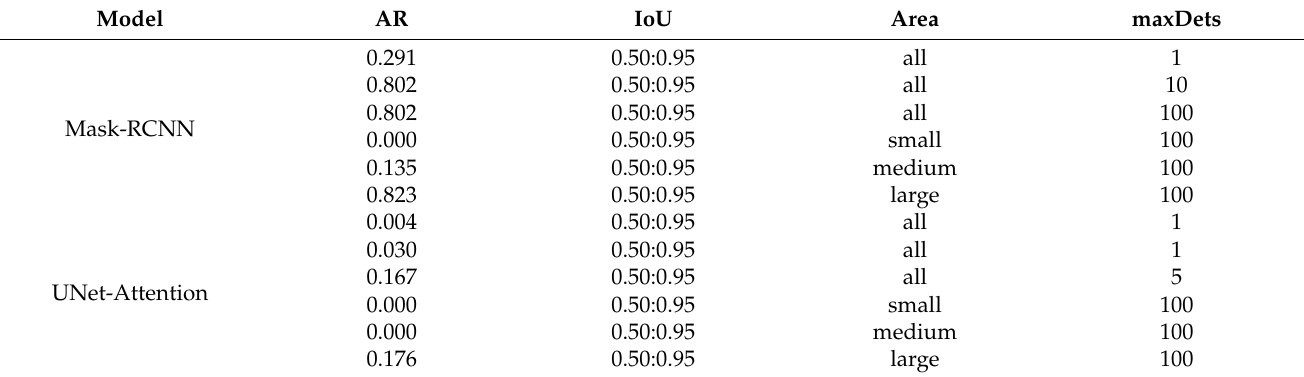
Table 2. The Average Recall (AR) rates of Mask-RCNN and UNet-Attention.